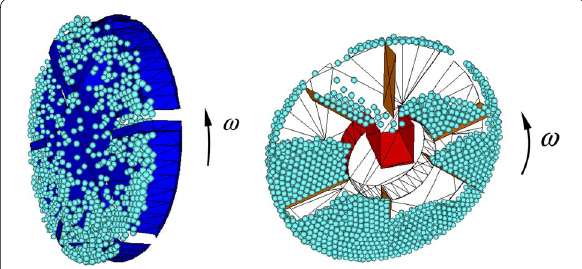
φ 8.53 m (Figure 12a) and the China Railway Construc- tion Corporation (CRCC) φ 7.8 m (Figure 12b). The